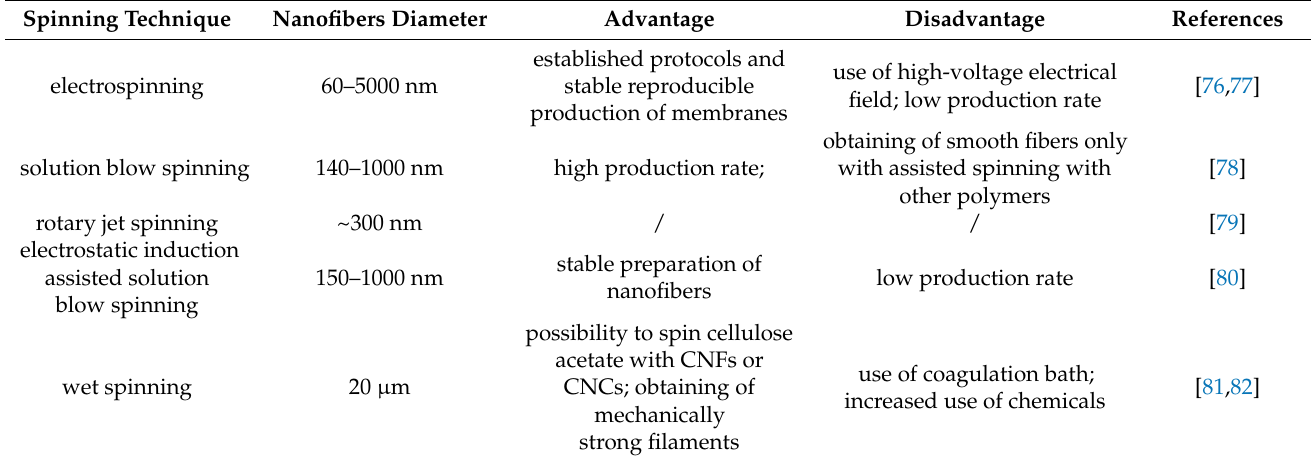
Table 3. Frequently used techniques for cellulose acetate nanofibers preparation, average diameter of nanofibers, and advantages/disadvantages of each technique from the aspect of using them for cellulose acetate